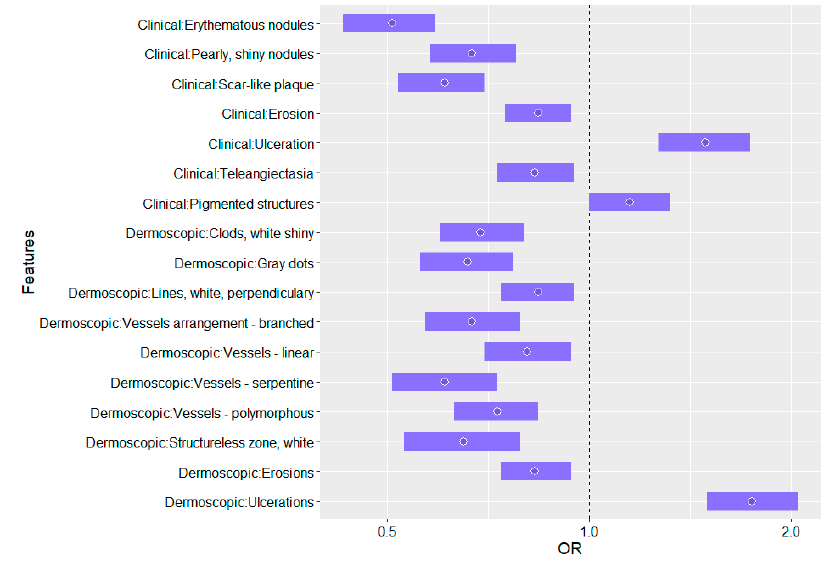
Figure 1. Influence of brachytherapy fractions on skin diagnostic outcomes.